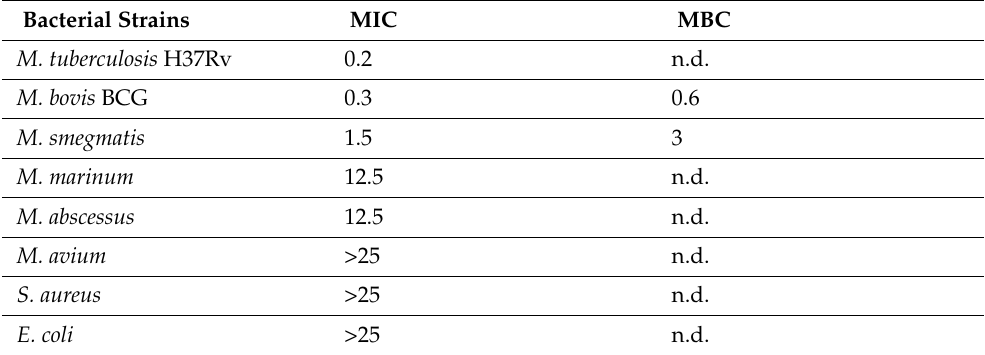
Table 1. In vitro antibacterial activity of compound 1 . MICs and MBCs values from three independent determinations in µ g/mL. 7H9 and 7H11 media were used for Mycobacterium species. LB medium was used for S. aureus and E. coli .